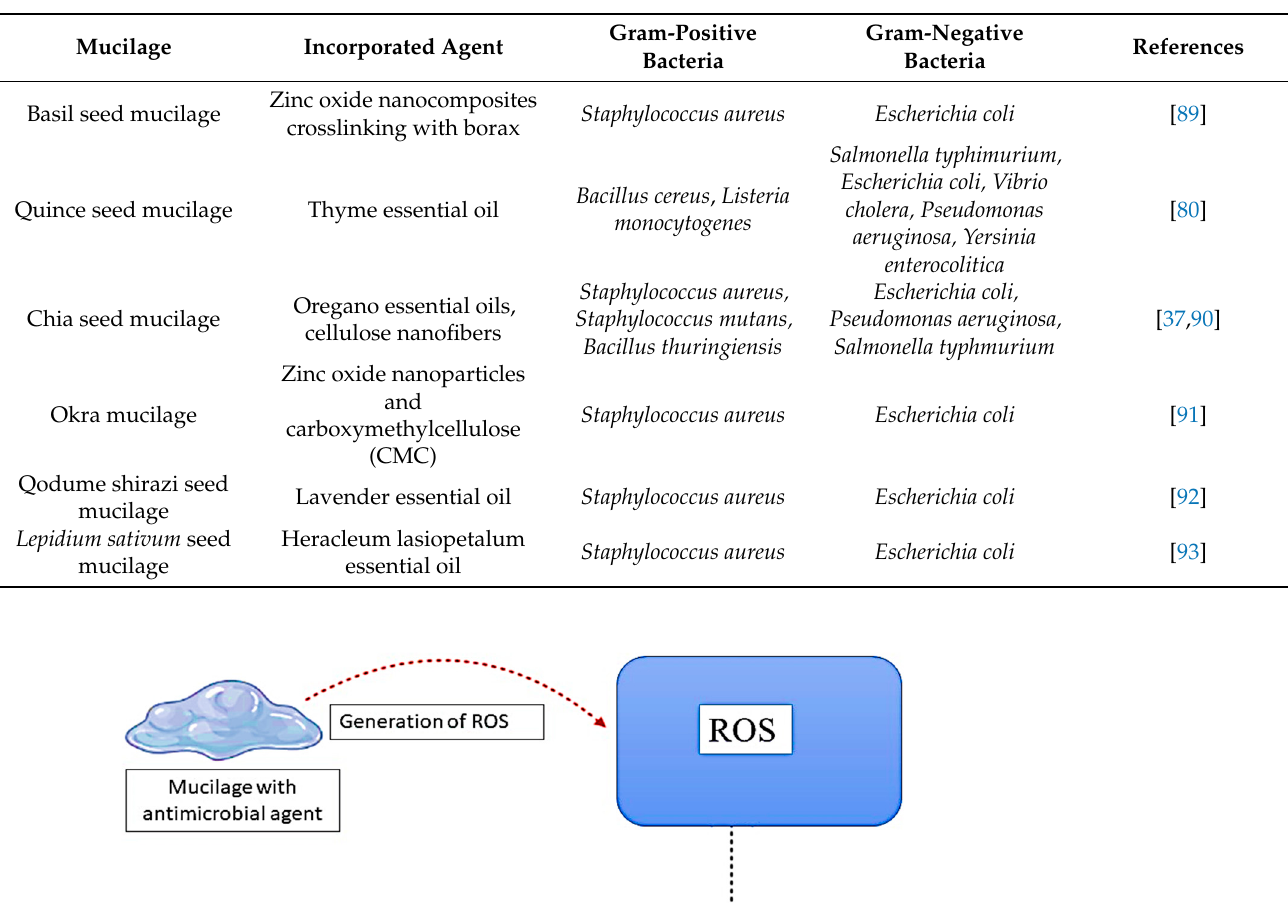
Table 3. Antimicrobial activity of different mucilage-containing plants.